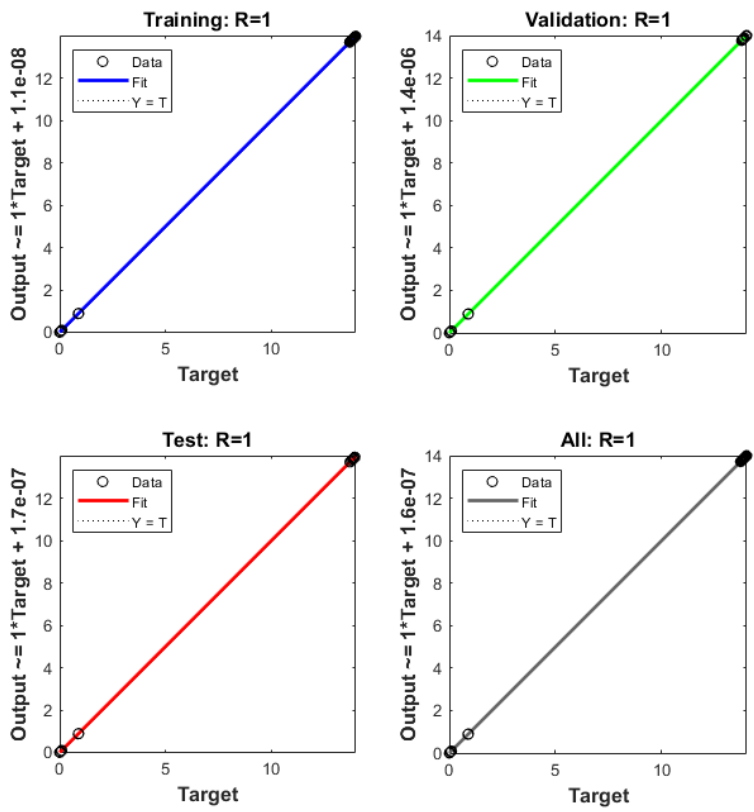
Figure 6. Case 1 Regression plots based on the nonlinear COVID-19 spreading model.